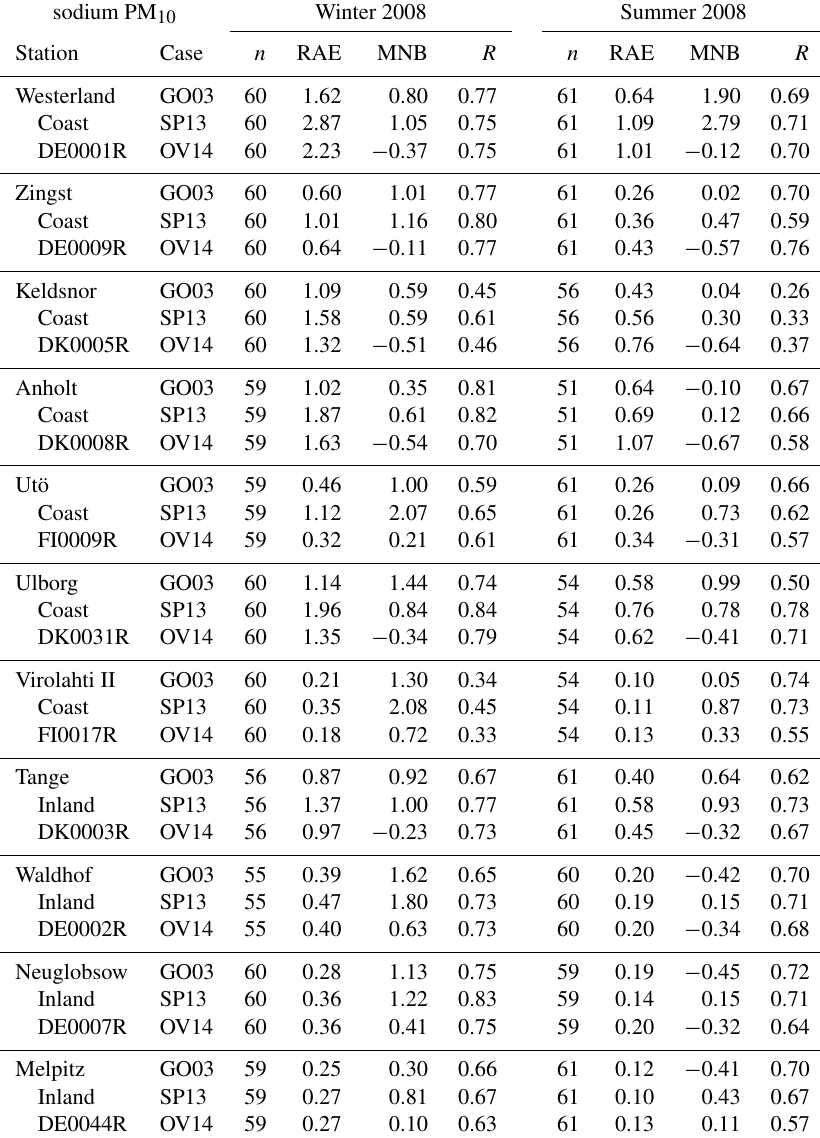
Table 3. Statistical evaluation for the comparisons between the modeled and measured Na + concentrations at 11 EMEP stations in the vicinity of the North and Baltic seas during winter (left) and summer 2008